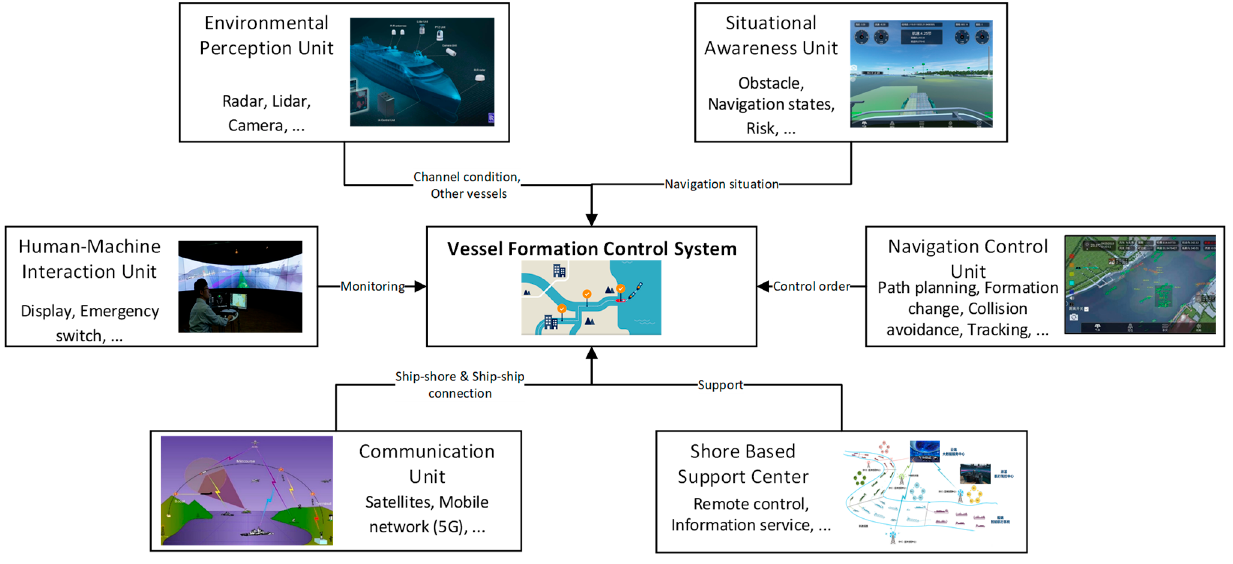
Figure 5. Main structure of the inland vessel formation control system.